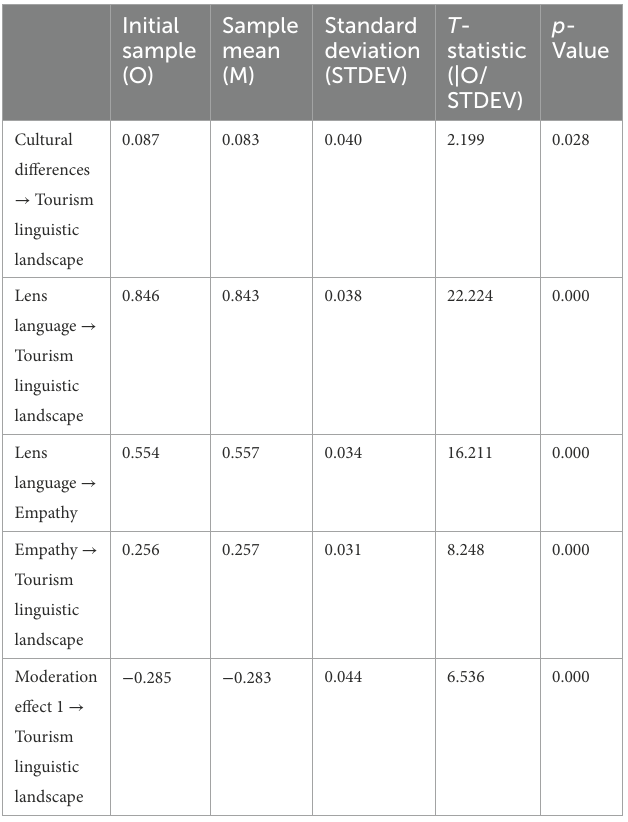
TABLE 4 Significance test results of path